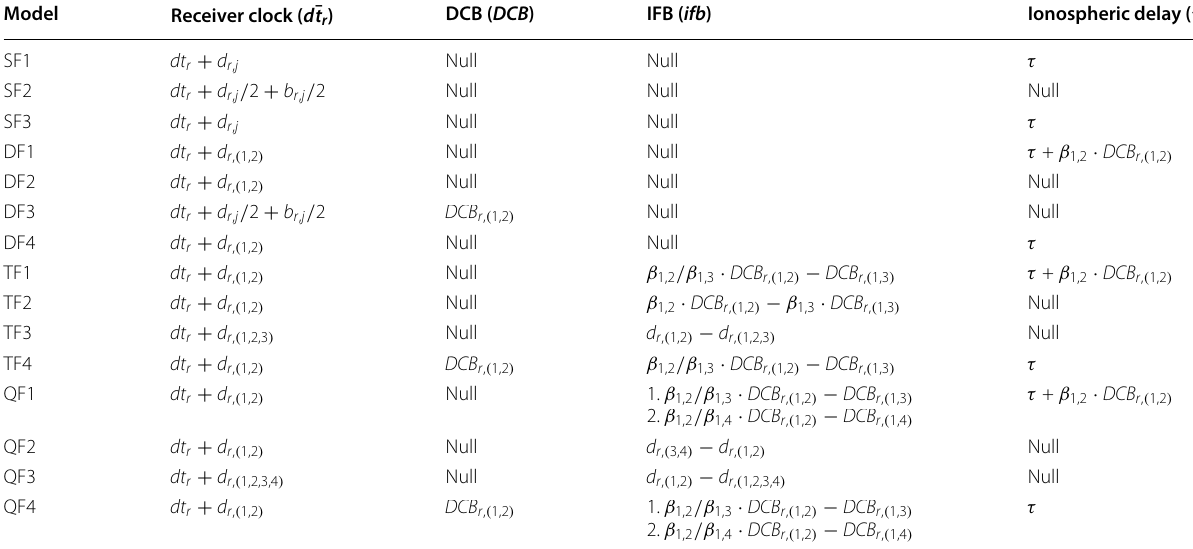
where dt r is the raw receiver clock offset, d r,j and b r,j denote the receiver pseudorange and carrier phase hardware delay on the j th frequency. d r , ( m , n ) = α m , n · d r , m + β m , n · d r , n . d r , ( 1,2,3 ) = e 1 · d r ,1 + e 2 · d r ,2 + e 3 · d r ,3 . d r , ( 1,2,3,4 ) = e ′